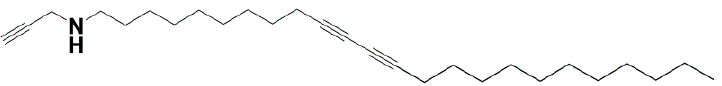
Figure A4. N -Methyl- N -(pentacosa-10,12-diyn)-propargylamine. For synthesis see reference [27].